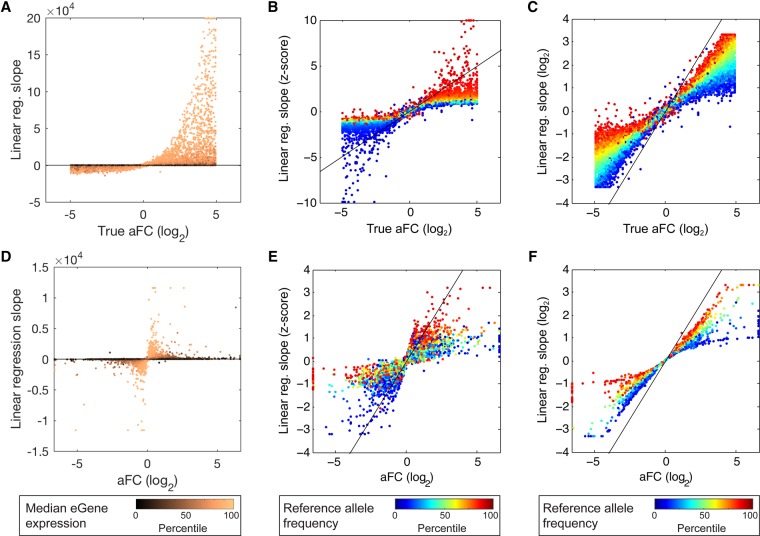
aFC compared with linear regression slope. (A–C) Slope of linear regression from 10,000 simulated eQTLs generated similarly to data shown in Figure 2. The true aFC value is compared with regression slopes from raw (A), z-scored (B), and log2 transformed (C) data. The color code represents median eGene expression (A) and reference allele frequency (B,C) with alternative color-coding for the same plots in Supplemental Figure S4. (D–F) Regression slope compared with aFC values estimated using GTEx eQTLs data from adipose subcutaneous.